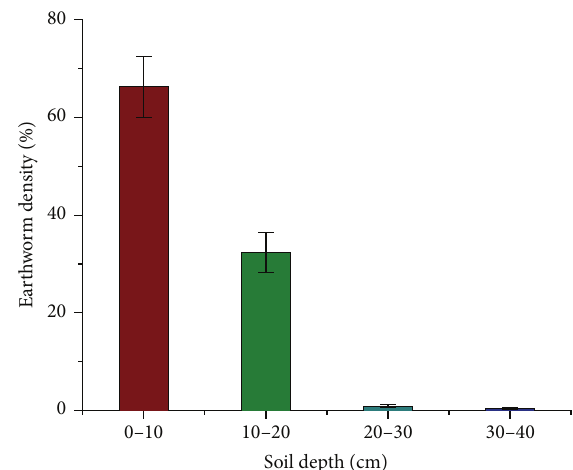
Figure 4: Showing concentration of earthworm density in different soil strata.